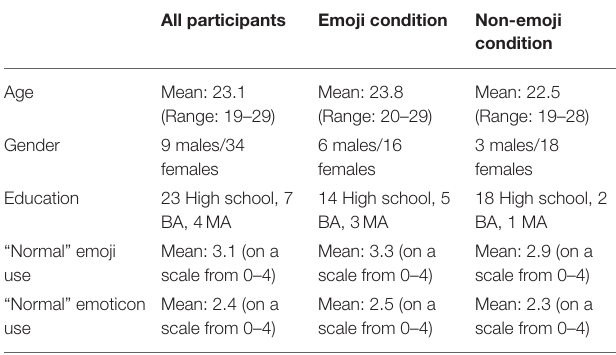
TABLE 1 | Information on the